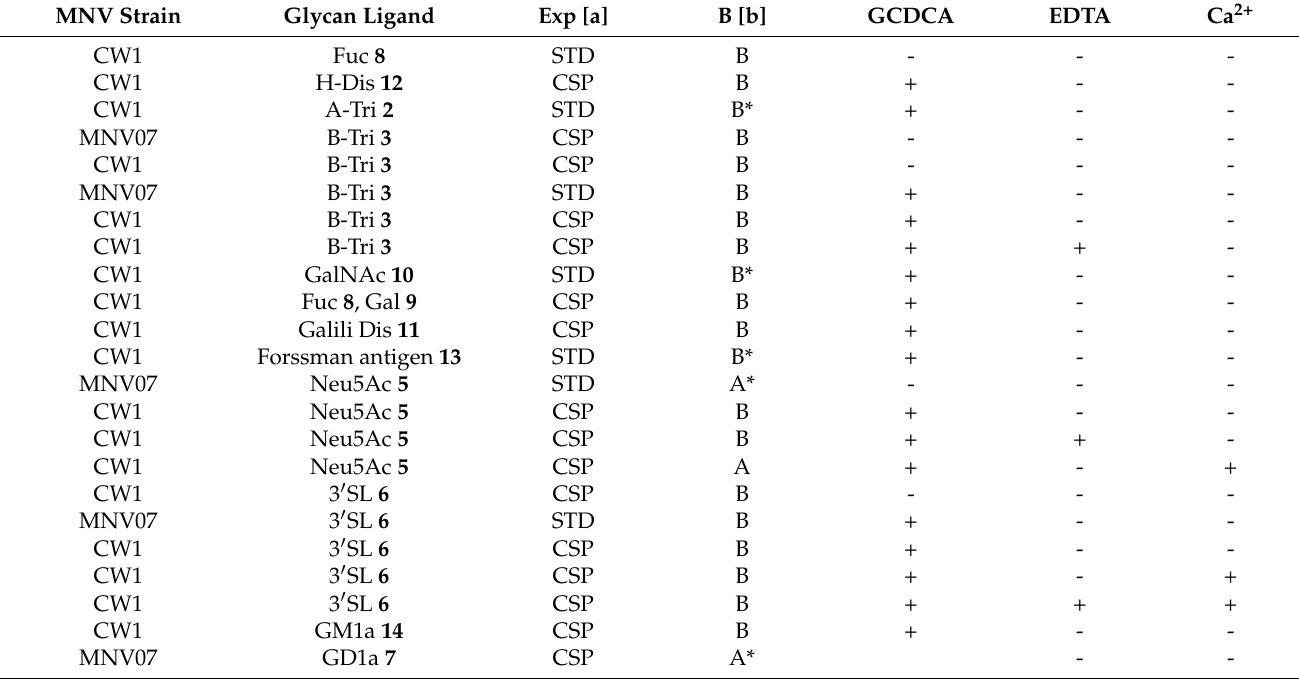
Table 2. Glycans tested negative for binding to MNV P-domain with and without GCDCA. NMR samples were prepared in the following buffers. A: 75 mM sodium phosphate, 100 mM NaCl (pH 6), A*: A with 20 mM sodium phosphate, B: 20 mM sodium acetate, 100 mM NaCl (pH 5.3), B*: B with sodium acetate-d3 in D2O. Additional experimental conditions such as temperatures and protein and ligand concentrations are given in Table